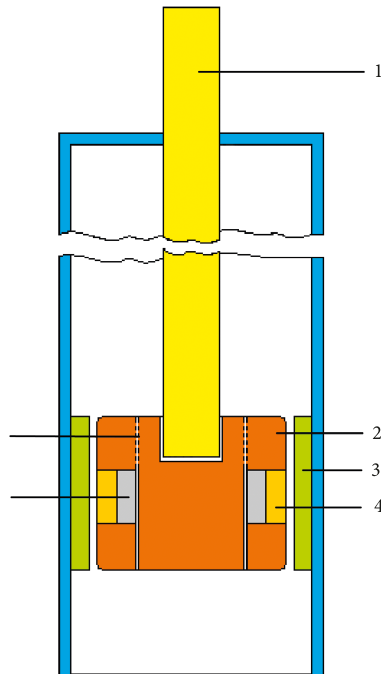
Figure 8: A longitudinal cross-sectional view of MR damper with permanent magnet: 1, rod; 2, piston; 3, flux ring; 4, coil; 5, permanent magnet; 6, magnetic gap